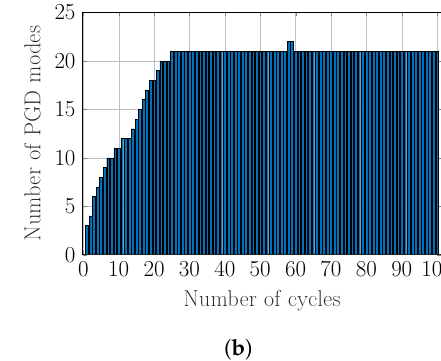
Figure 7. ROB size using different orthonormalisation algorithms. ( a ) number of PGD modes using GS; ( b ) number of PGD modes using (R)SVD ( (cid:101) tol = 10 − 8